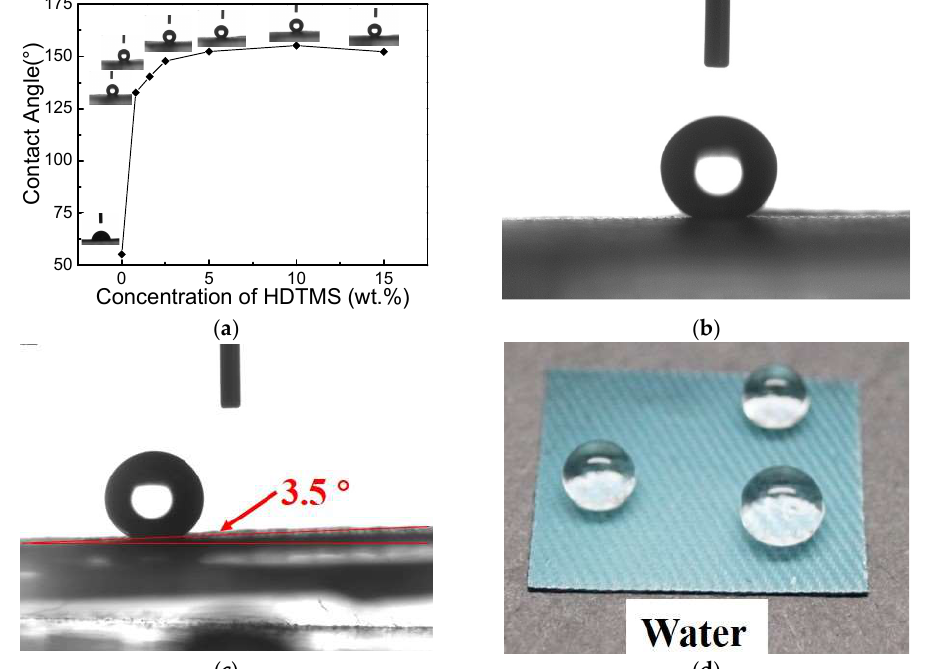
Figure 8. ( a ) The effect of HDTMS concentration (wt %) on water CA of the structurally colored fabrics; ( b ) CA and ( c ) SA of HDTMS-SiO 2 structurally colored fabric with HDTMS concentration of 10 wt %; ( d ) Three water droplets stand on the structurally colored fabric.